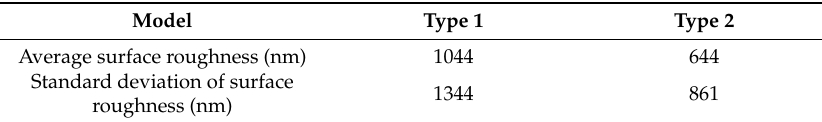
Figure 11. Peak-to-peak open circuit voltage at various input frequencies and accelerations when channels of different surface roughness are used: ( a ) type 1; ( b ) type 2.